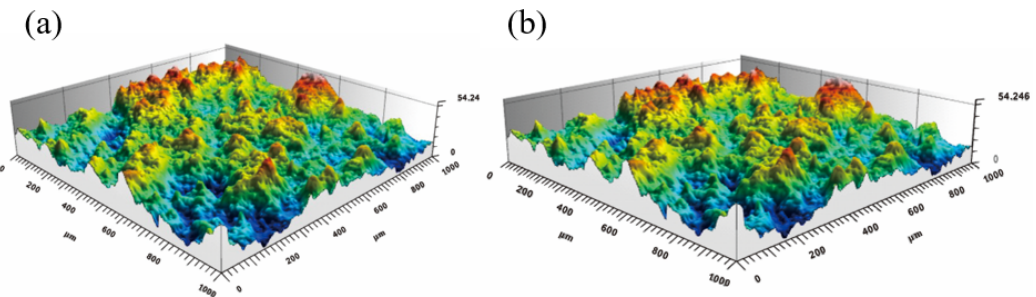
Figure 3. Three-dimensional morphology analysis of the coating surface ( a ) KNN ( b ) KNLN coating.